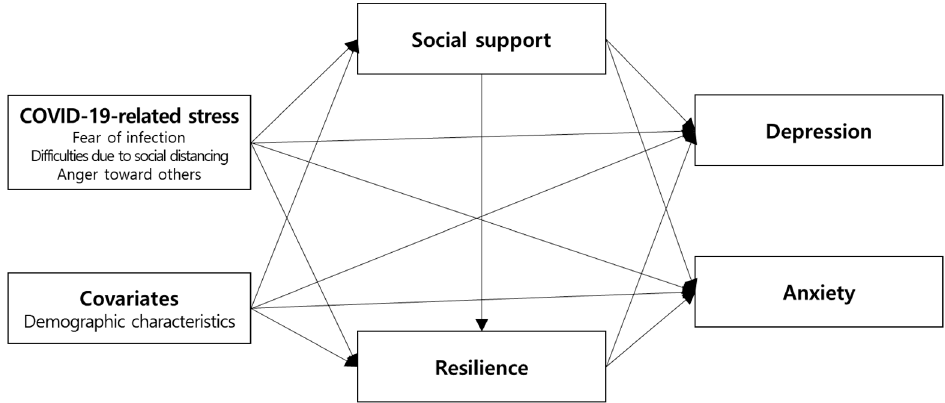
Figure 1. A hypothetical model of the study.